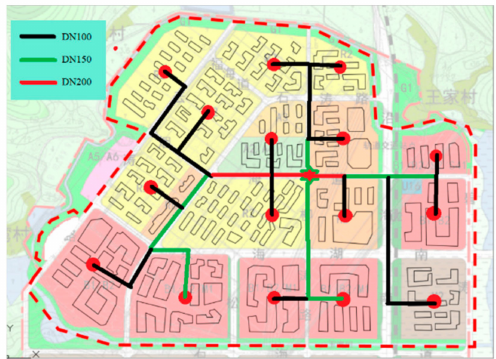
Figure 11. The pipeline network scheme with the minimum path as the optimization